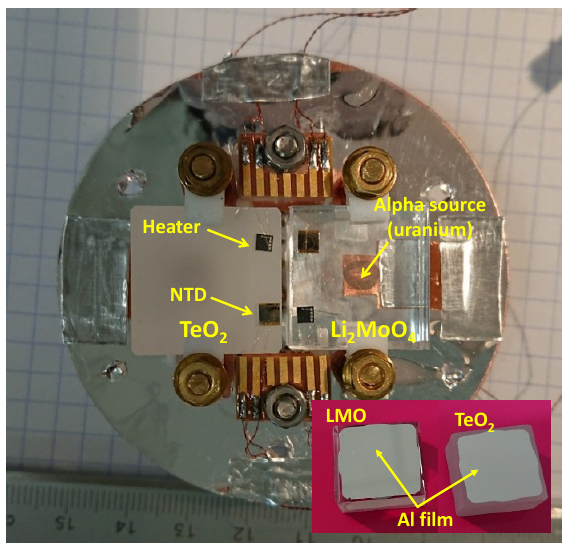
Figure 2 . Photograph of the set-up used for the CROSS-prototype tests. The Li 2 MoO 4 and TeO 2 crystals, with a size of 20 (cid:2) 20 (cid:2) 10 mm, are visible. The NTD Ge thermistors and the heaters are glued on the upper crystal surface. The uranium sources are placed below the crystals (the one irradiating Li 2 MoO 4 is visible in transparency). No Al (cid:12)lm is deposited in this case. The copper disk which supports the crystals is covered with a re(cid:13)ective foil. Two same-size crystals can be assembled symmetrically below the copper disk. A light detector (not shown here), consisting of a (cid:11) 44 (cid:2) 0.175 mm Ge wafer coated by a SiO thin layer to reduce the light re(cid:13)ection, can face two crystals simultaneously at both sides of the copper disk. The inset at the bottom right corner shows Li 2 MoO 4 and TeO 2 crystals with a 20 (cid:2) 20 mm side coated by a 10 (cid:22) m thick Al